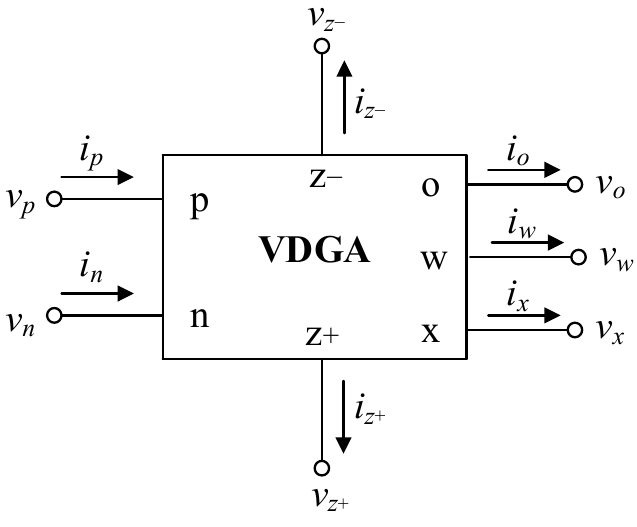
Figure 1. Symbol of VDGA.